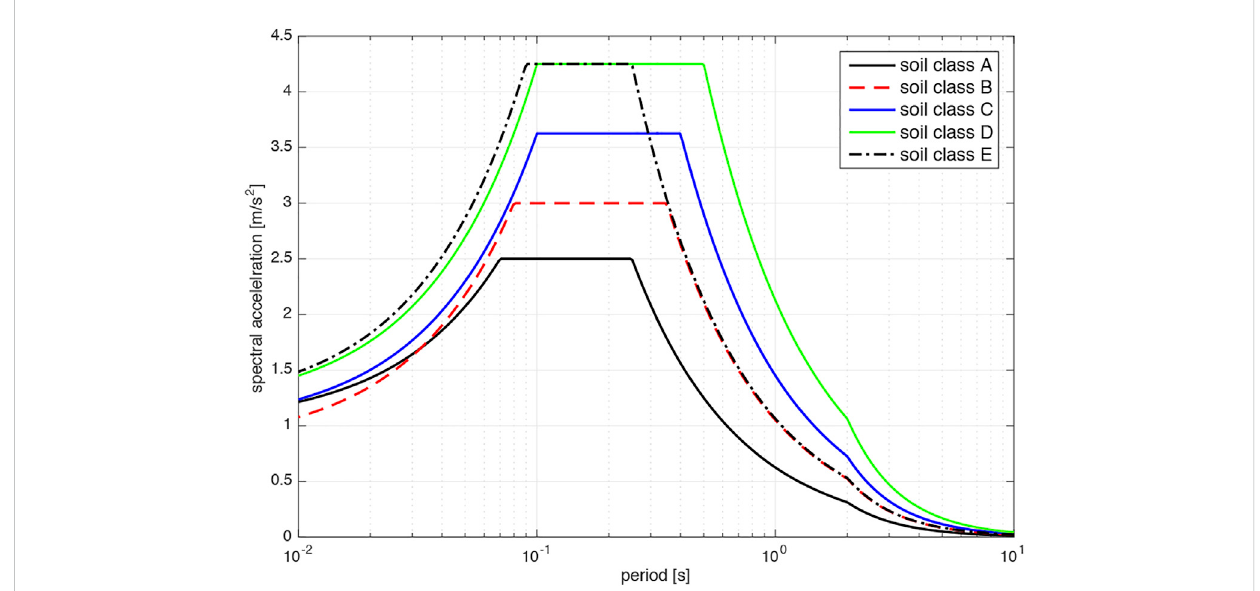
FIGURE 8 Elastic response spectra for the different soil classes in a seismic zone Z2 (SIA 261